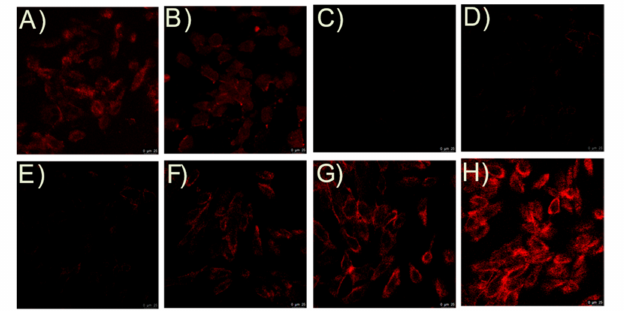
Figure 9. Fluorescence images of H9C2 with TCF-ester and TCF-ether. Cells were incubated with TCF-ester in the ( A ) presence or ( B ) absence of BSA (23 mg/mL). Cells were incubated with TCF-ether in the ( C ) presence or ( D ) absence of BSA (23 mg/mL). Cells were pre-incubated with the probe system for 30 min and then incubated with CORM-2 ( E ) 0 µ M, ( F ) 5 µ M, ( G ) 20 µ M, and ( H ) 40 µ M, for another 30 min at 37 ◦ C. Scale bars, 25 µ